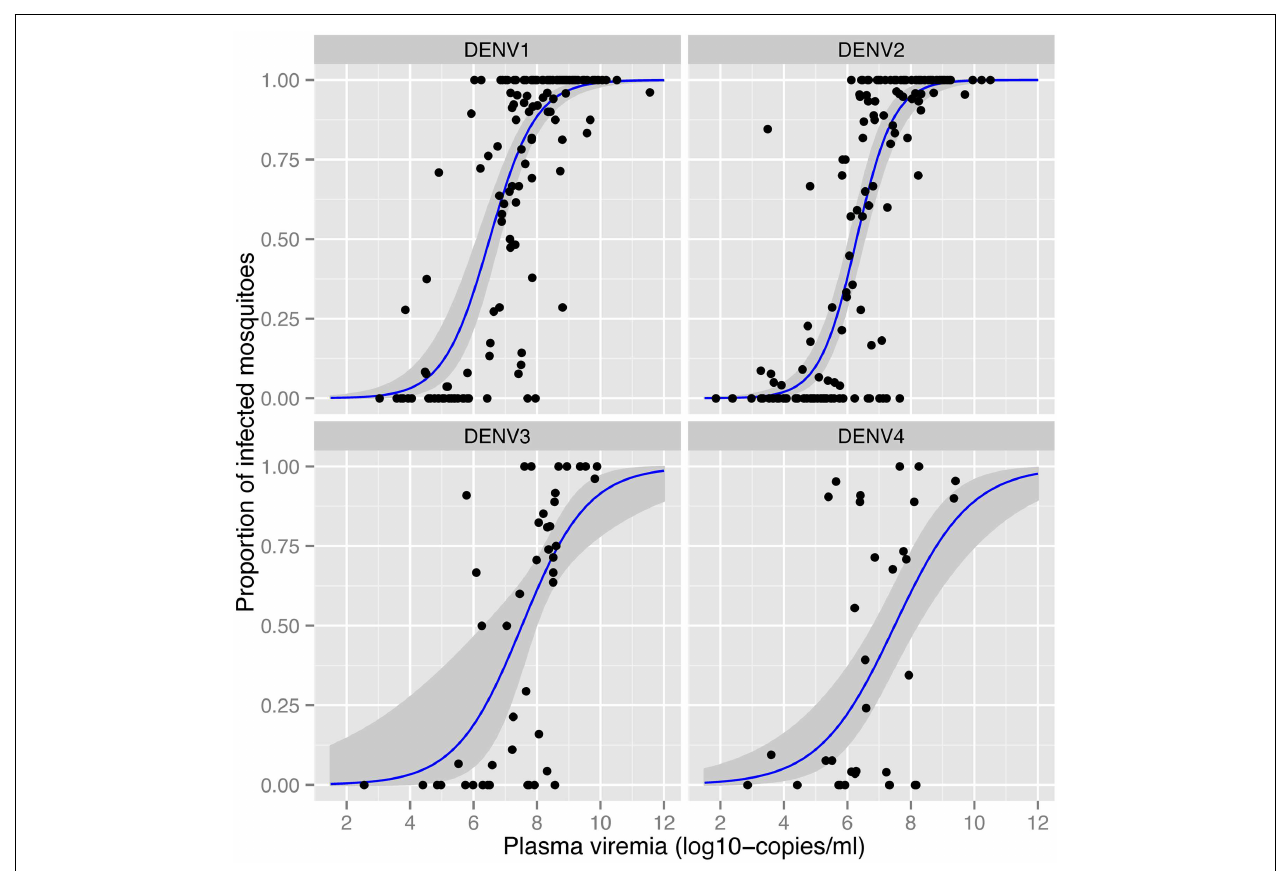
the proportion of DENV-infected mosquitoes after a single blood-feeding episode. Estimated associations and the 95% confidence intervals are shown in the blue lines and gray shading, respectively. Image reproduced with permission from the